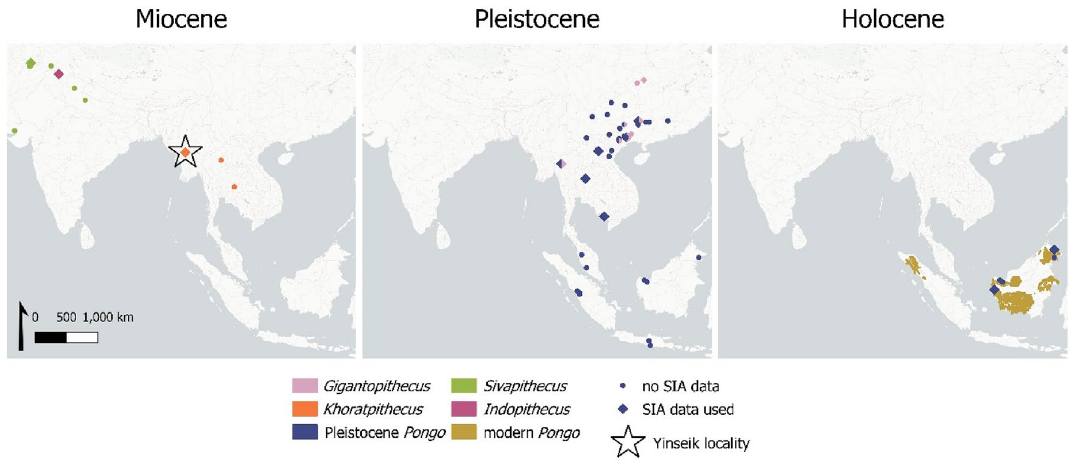
Figure 1. Location of fossil pongine localities from the Miocene to the Holocene in Southern Asia, Southeast Asia and Southern China including the present distribution of extant orangutans. The stable isotope data